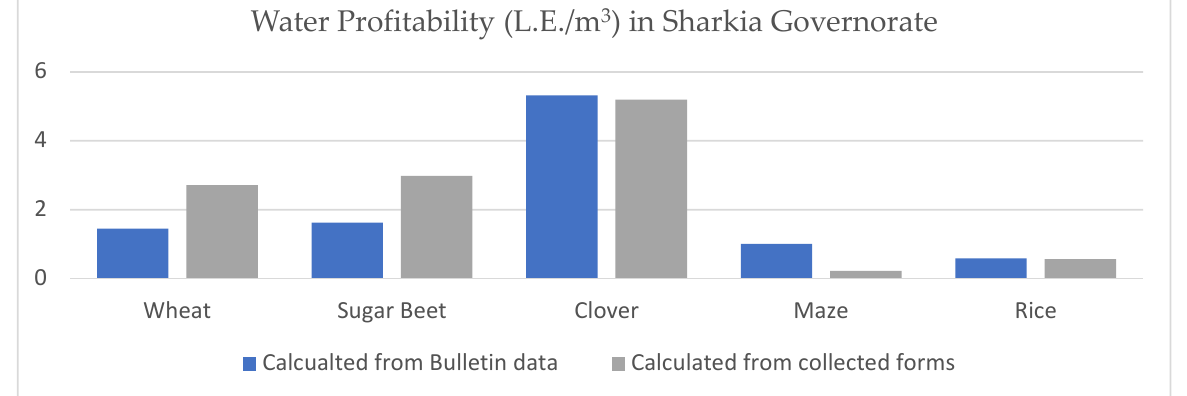
Figure 2. Water profitability of Sharkia governorate from Bulletin data compared to collected forms.